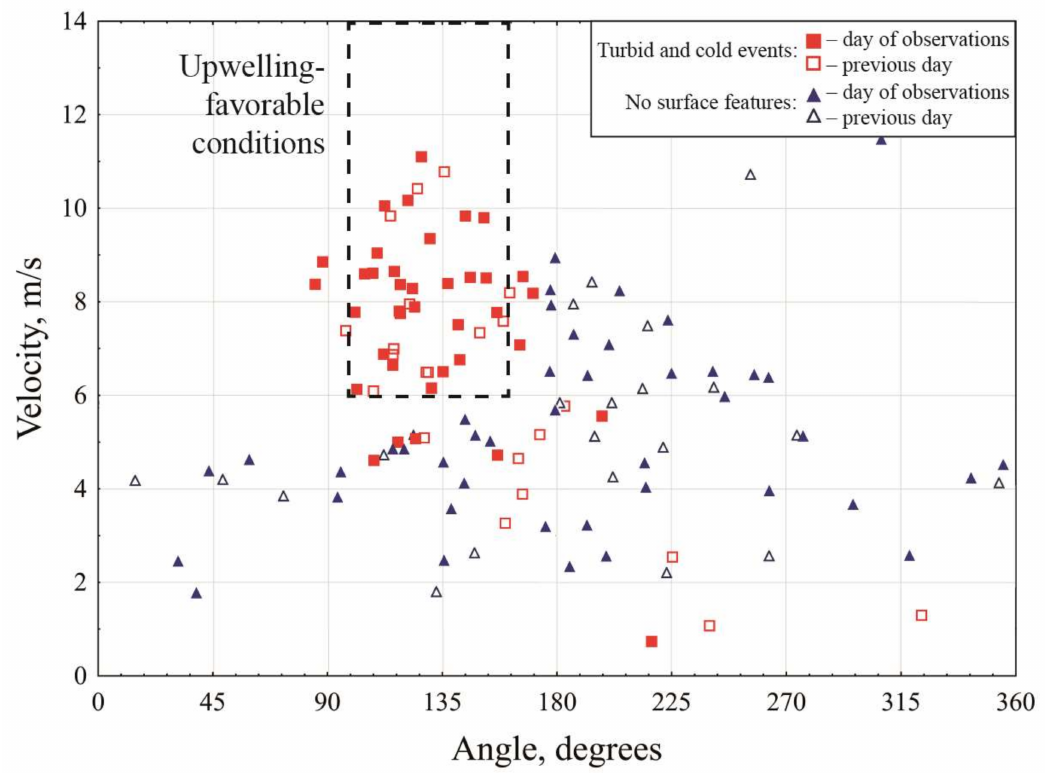
Figure 7. Wind forcing conditions at the Indigirka Delta region during periods of presence (red squares) and absence (blue triangles) of cold and turbid events detected on satellite imagery. For each satellite image, averaged wind forcing conditions are shown during the day of satellite observation (filled symbols) and during the preceding day (empty symbols). The black dashed rectangle indicates upwelling-favorable wind forcing